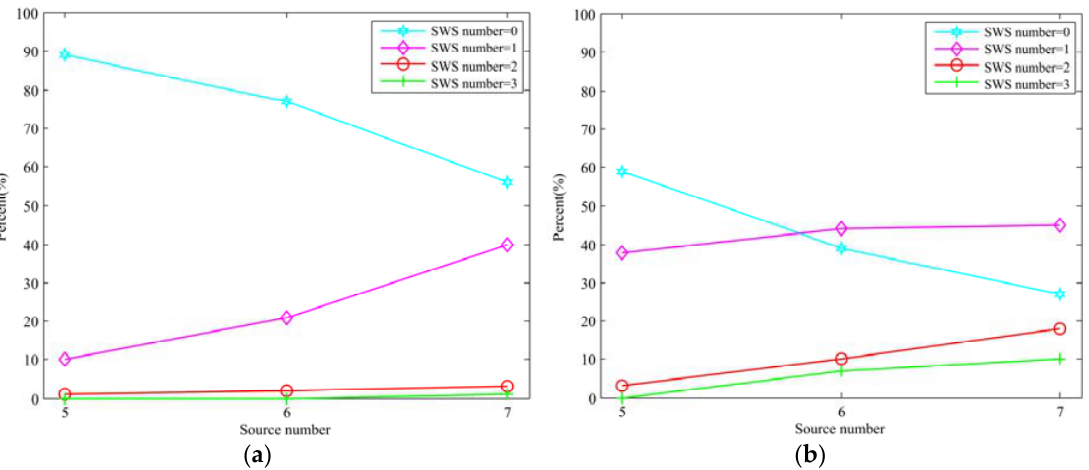
Figure 2. Statistical analysis for the existence of the SWS in different sound source number ( a ) Angle between sources is 50°; ( b ) Angle between sources is 30°.